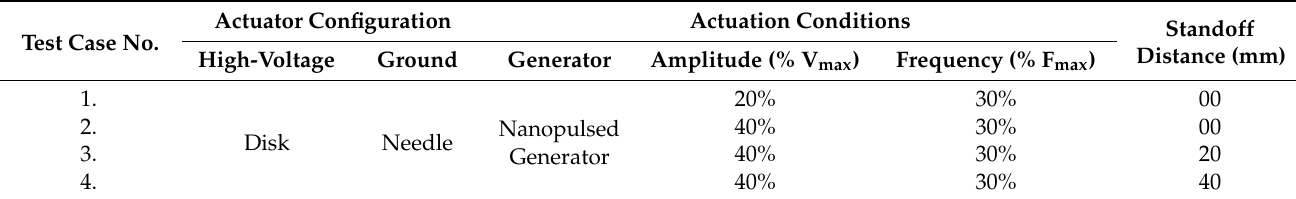
Table 1. Plasma actuated experimental